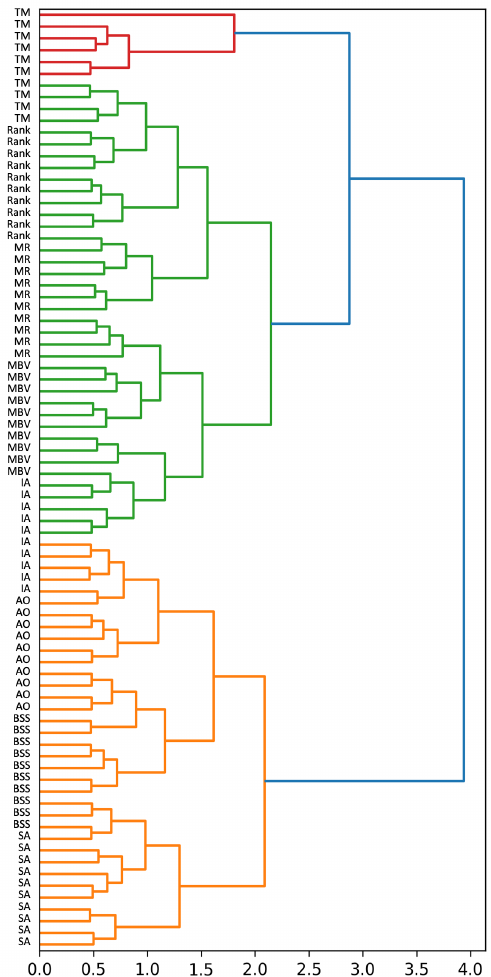
Figure 10. Task II–Clustering using NRC achieves average results at most: small groups are separated in several cases. Colors are assigned automatically by the plotting